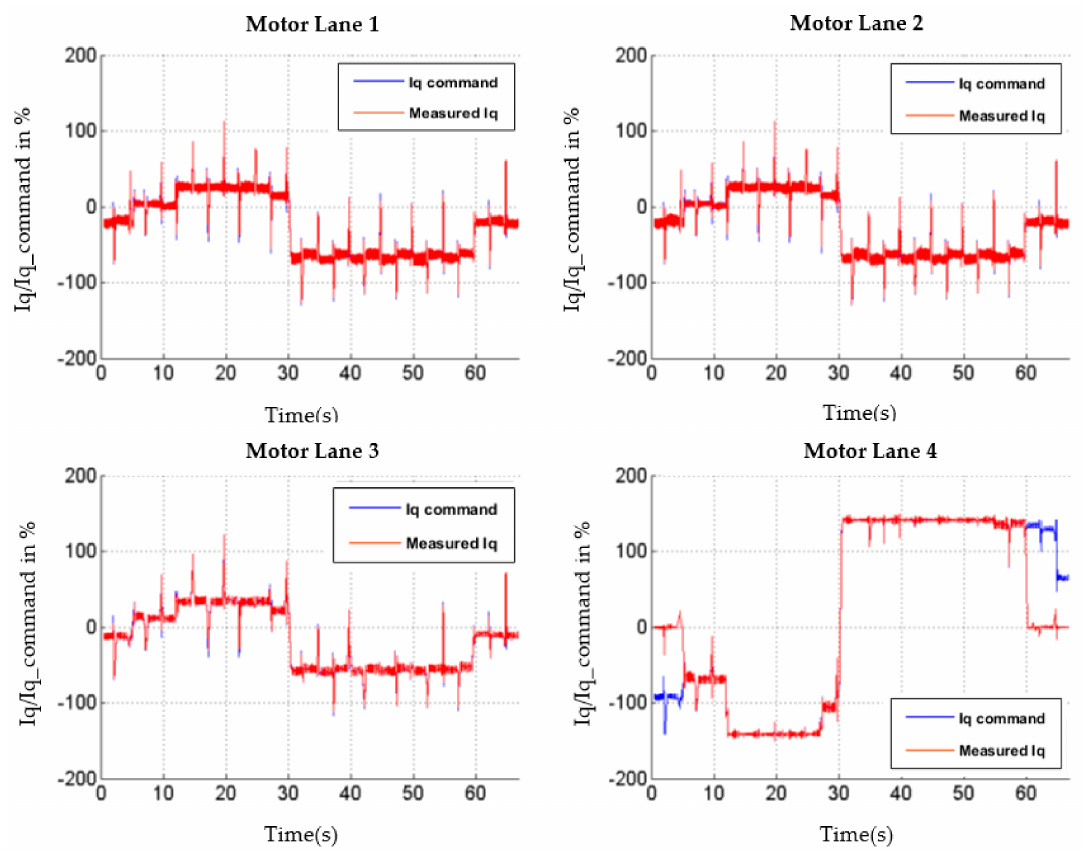
Figure 15. Iq current responses of the four motor lanes in faulty operation